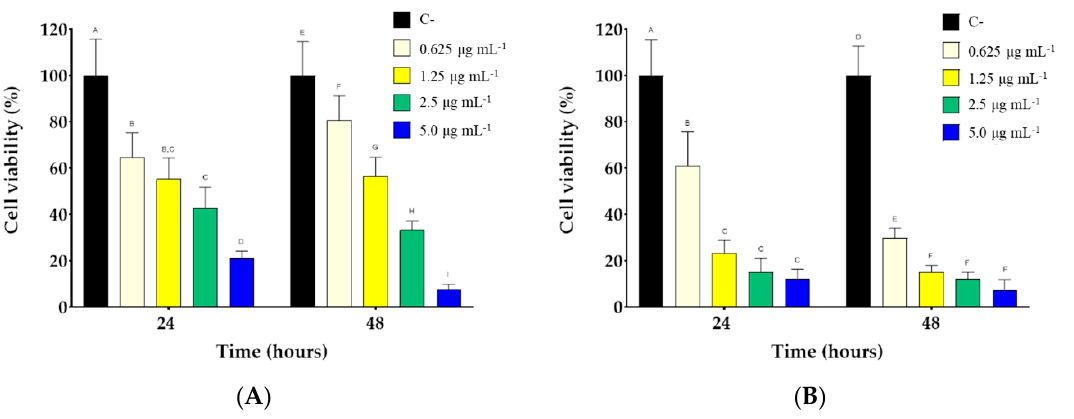
Figure 5. Cell viability of BALB/3T3 ( A ) and MDA-MB231 cells ( B ) treated with DOX@HA-SANPs (drug concentration from 0 to 5 µg/mL) after 24 and 48 h. Within each group, different letters denote statistical differences for p < 0.05, n = 5. Reprinted from Ref. [105].